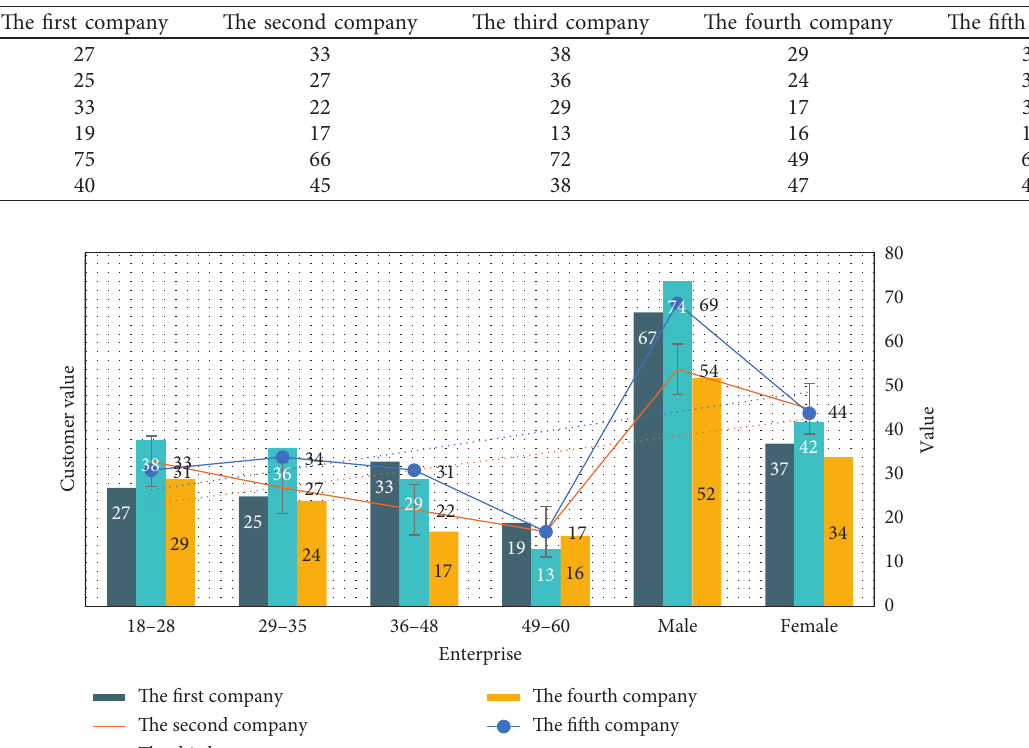
Figure 2: Distribution of employees in different